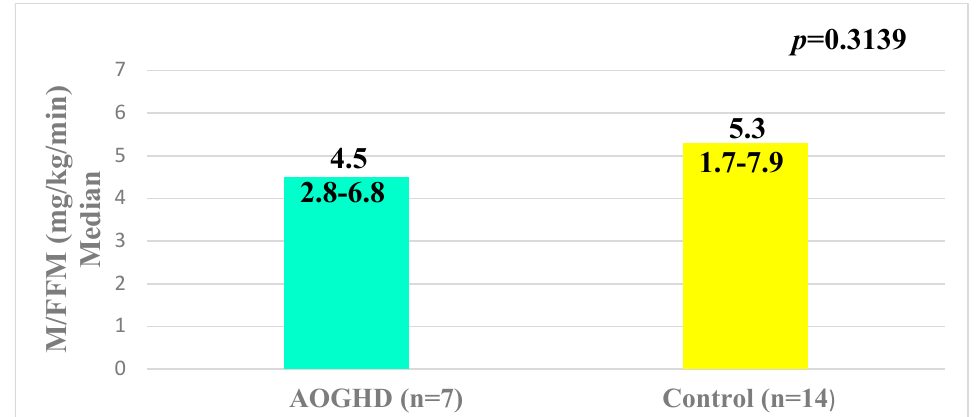
Figure 1. Insulin sensitivity in patients with COGHD vs. AOGHD, COGHD vs. control subjects COGHD and AOGHD vs. control subjects AOGHD. M/FFM was adjusted for age and BMI. Abbreviations: COGHD: patients with childhood-onset GH deficiency; AOGHD: patients with adulthood-onset GH deficiency; M/FFM: M-value normalized per kg free fat mass. The data refer to the median, minimum, and maximum.